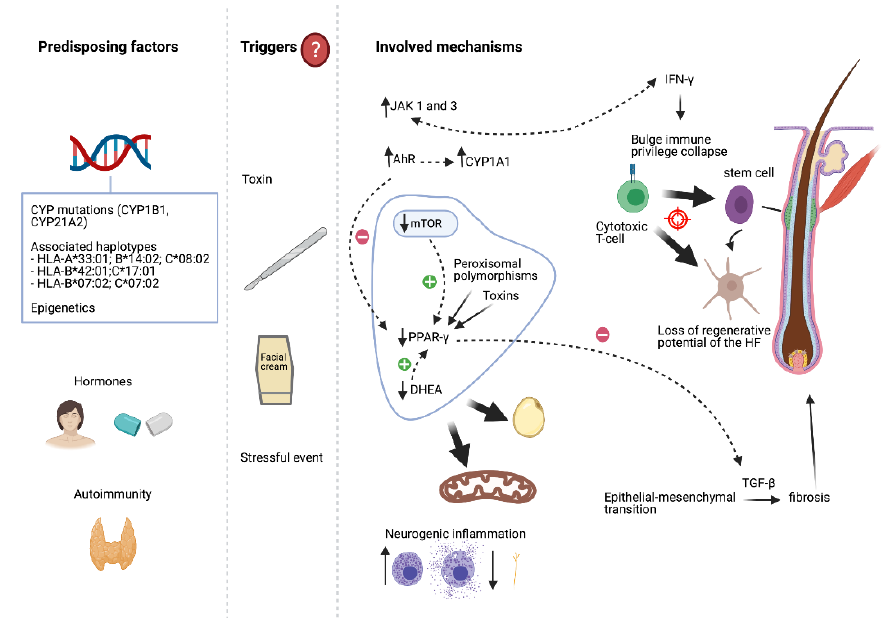
Figure 1. Different unknown triggers, such as facial creams/sunscreens, environmental toxins, surgery, or a stressful situation, may lead to FFA in genetically susceptible individuals. Autoimmunity may also contribute to the predisposition, so people with one autoimmune disease are more likely to have another one. Hormonal factors probably play a role in the development of FFA. Discontinuous lines indicate a regular relationship between two elements. JAK: Janus kinase; AhR: aryl hydrocarbon receptor-kynurenine; mTOR: mammalian target of rapamycin; PPAR-γ: peroxisome proliferator-activated receptor γ; DHEA: dehydroepiandrosterone; HF: hair follicle; IFN: interferon; TGF: transforming growth factor; HLA: human leukocyte antigen; CYP: cytochrome. Created with BioRender.com (accessed on 1 March 2021)